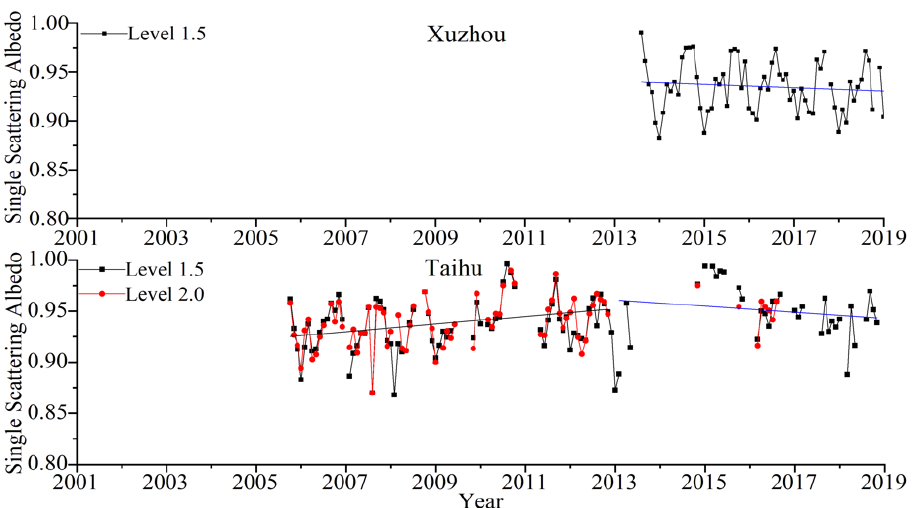
Figure 9. Temporal variations of monthly variations of AERONET SSA values.